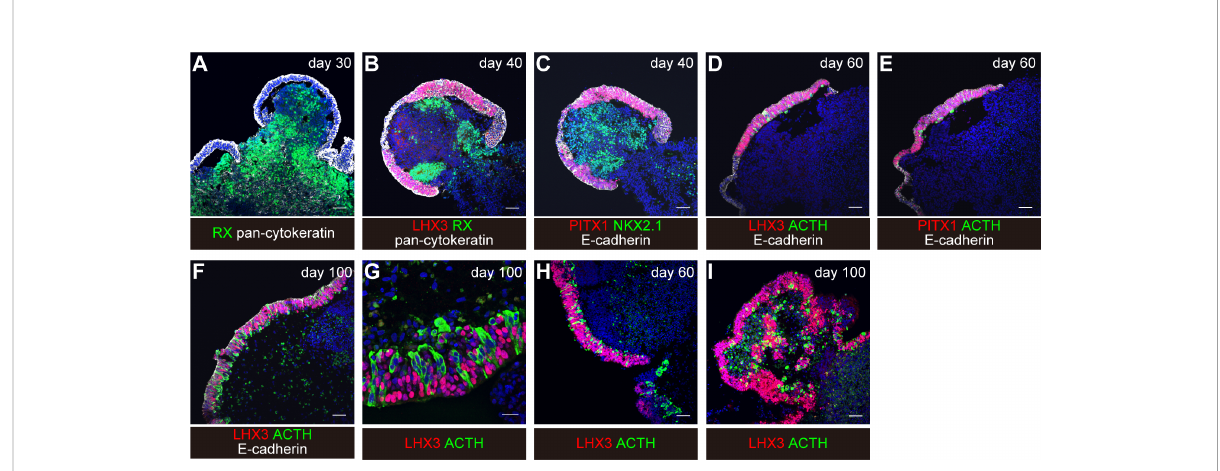
FIGURE 4 Induction of differentiation of human iPSCs into corticotroph cells. From “ Hypothalamic contribution to pituitary functions is recapitulated in vitro using 3D-cultured human iPS cells, ” by T. Kasai and H. Suga, 2020, Cell Reports 30, 18-24. e15.